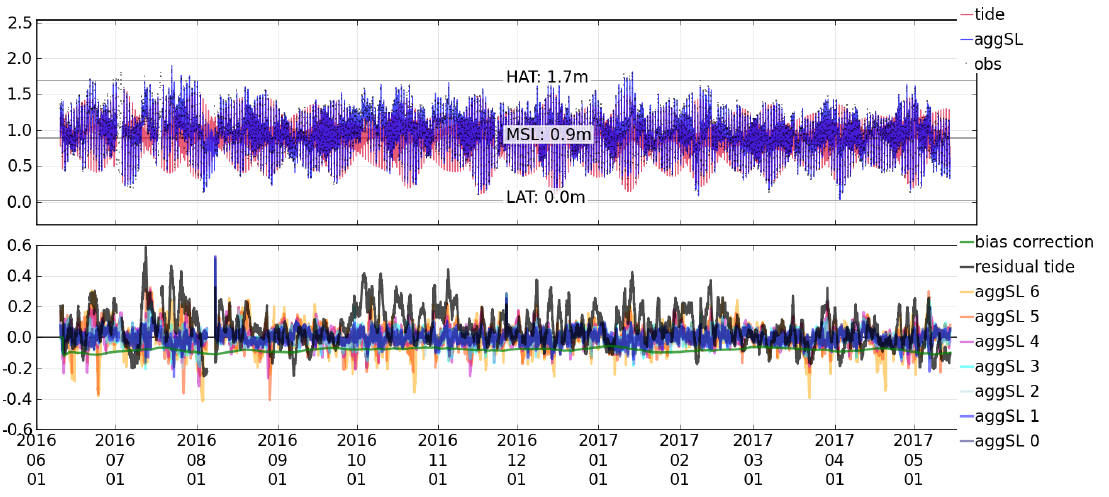
Figure 5. Example time series record for location at Melbourne ( 23 in Figure 4 ); Upper panel shows total still water levels relative to conventional tidal benchmarks. Lower panel shows error signals and bias correction evolution. Errors (‘residuals’) are shown overlaid for standard tides and aggregate forecasts (‘aggSL’) categorised by forecast lead time; each continuous aggSL timeseries is concatenated from forecast lead times of 0–24 h (aggSL0), 24–48 h (aggSL1), ... , 144–168 h (aggSL6). An overall reduction in error variance is apparent between standard tides and aggregate forecasts; errors grow with forecast lead time. Large reduction in error variance relative to harmonic tides is